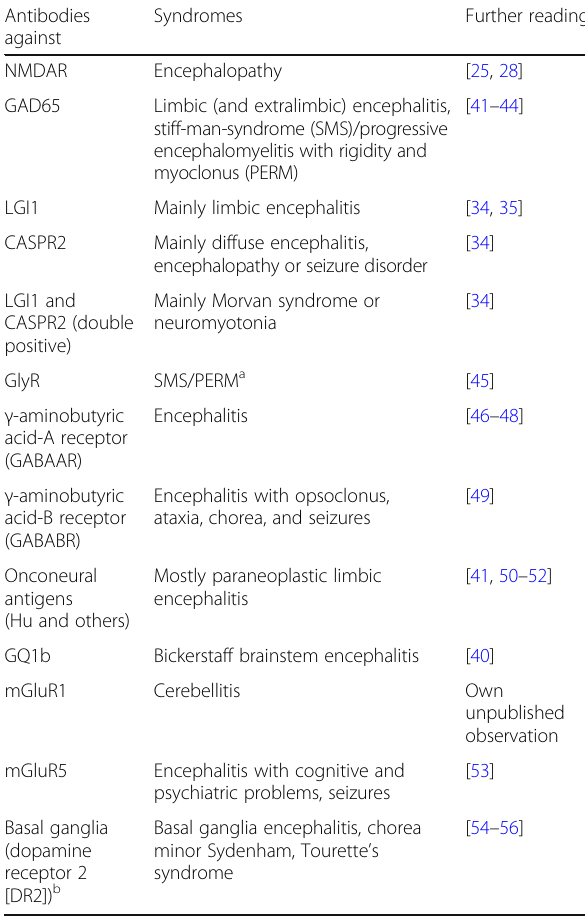
Table 3 Antibodies and encephalitic syndromes in children and